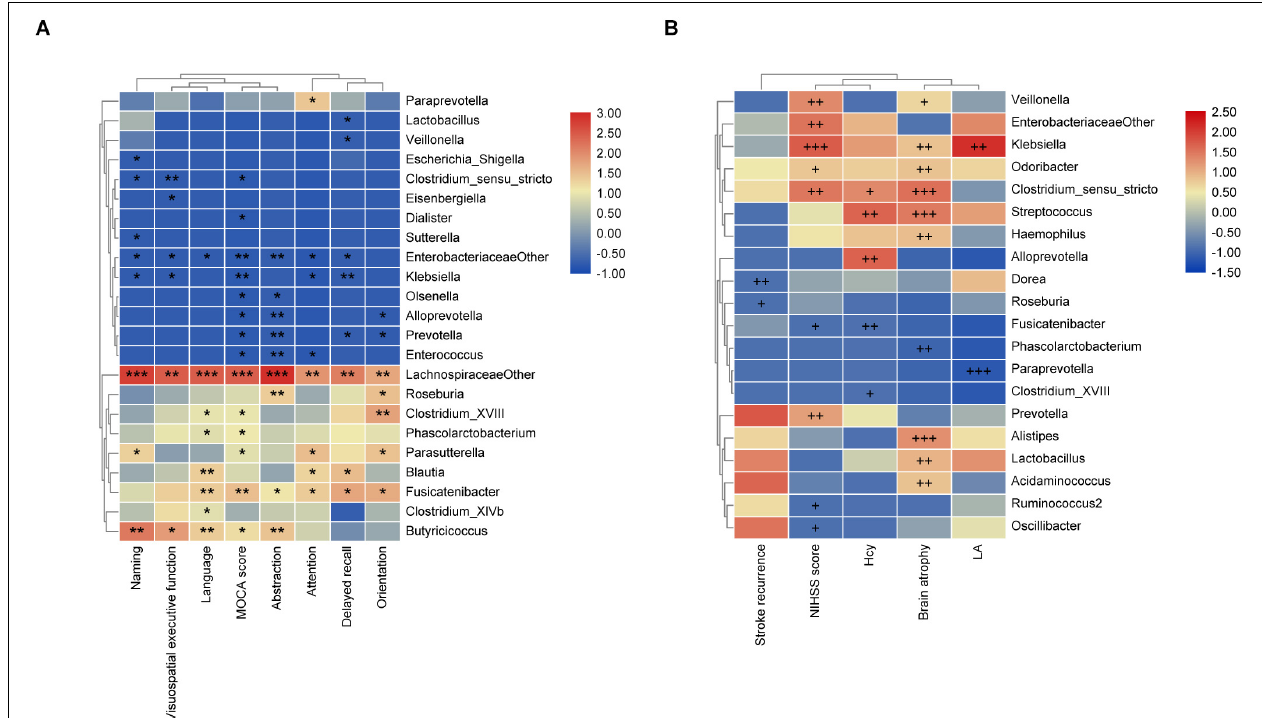
FIGURE 3 | The associations of gut microbiota (GM) with MoCA scores and the risk factors for PSCI. (A) Heatmap of spearman rank correlation analysis between GM and MoCA scores and its sub-variables. (B) Heatmap of spearman rank correlation analysis between GM and the risk factors for PSCI. Red means positive correlation and blue means negative correlation. * P < 0.05, ** P < 0.01, *** P < 0.001, + P < 0.1, ++ P < 0.05, +++ P <